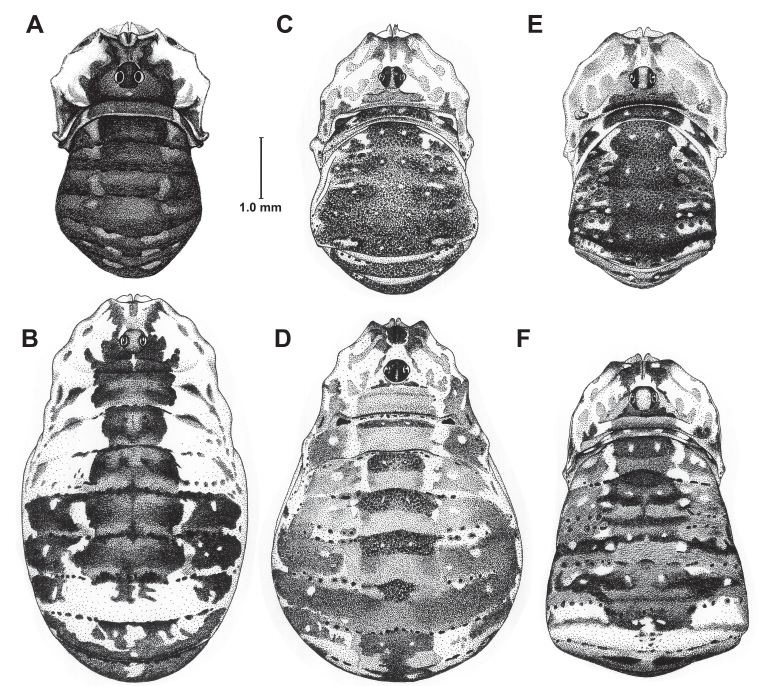
Fig. 3. Body of Leiobunum C.L. Koch, 1839, dorsal view. A–B. Leiobunum rupestre Herbst, 1799, Germany, Mt. Arber, CJM136. A . ♂. B . ♀. — C–D . Leiobunum gracile Thorell, 1876, Denmark. C . ♂, 2 km N of Skærbæk, CJM3530. D . ♀, Asp, CJM3531. — E–F . Leiobunum apenninicum (Martens, 1969), France, Alpes-Maritimes. E . ♂, CJM1508. F . ♀, CJM2747. Drawings by K.